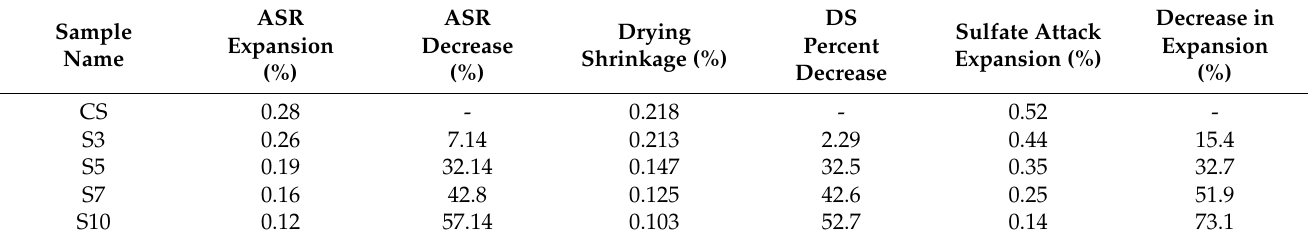
Table 7. Variation in Length (%) of Mortar Bars Due to Expansions and